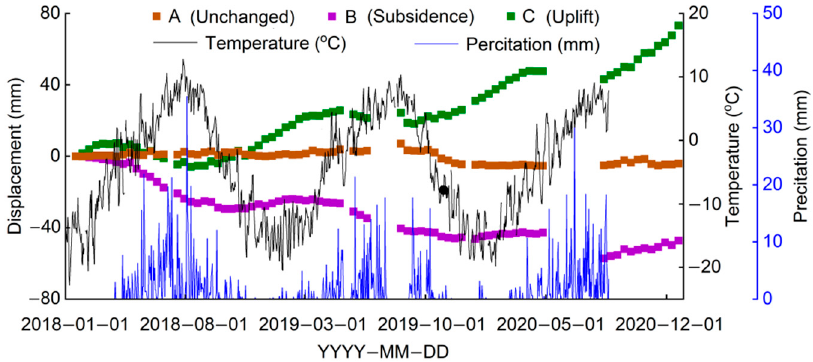
Figure 4. Time series displacement for different selected feature points in the natural